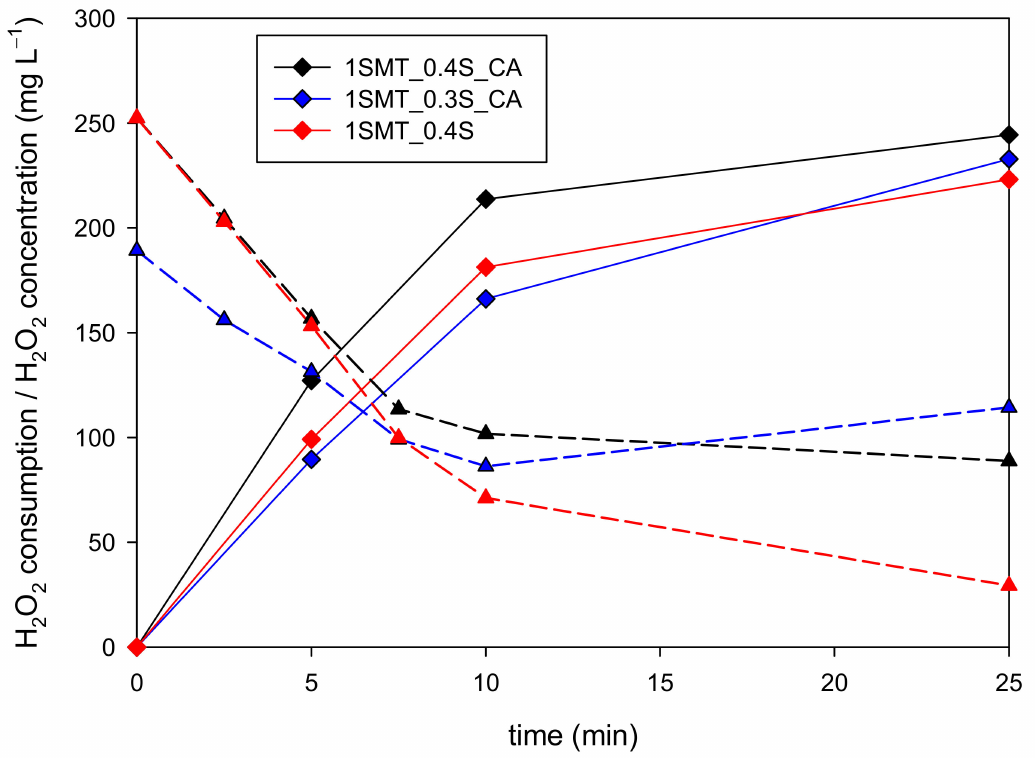
Figure 6. Comparison of H 2 O 2 consumptions (continuous lines) and concentration (dashed lines) profiles obtained with the 1SMT_0.4S_CA, SMT_0.3S_CA and 1SMT_0.4S dosage strategies during the transition stage of SMT contaminated water